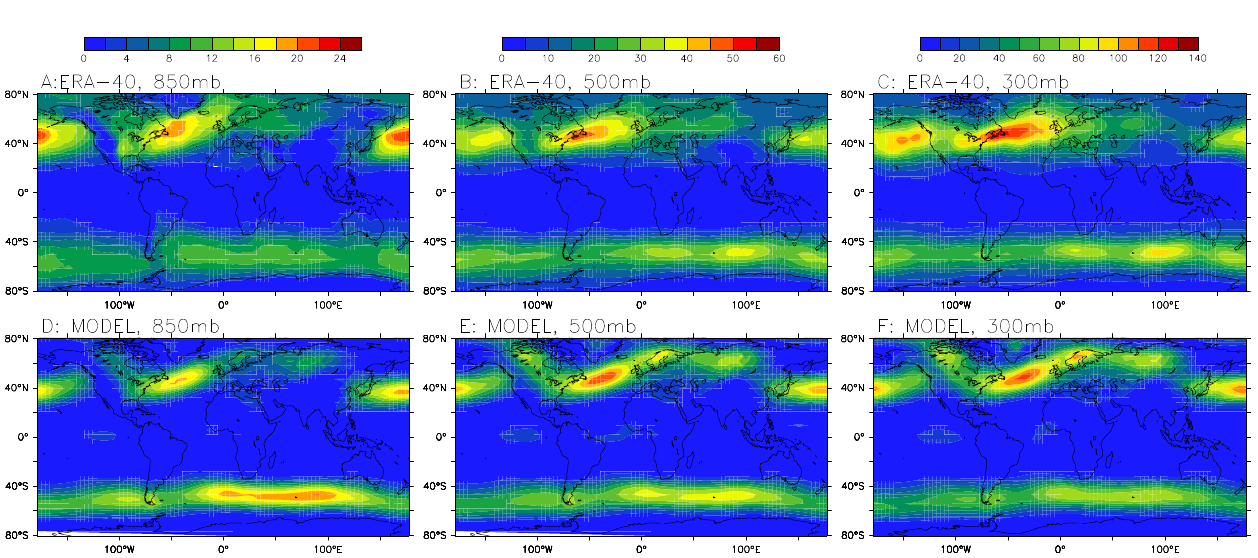
i (in m 2 s − 2 ) for December-January-February. k